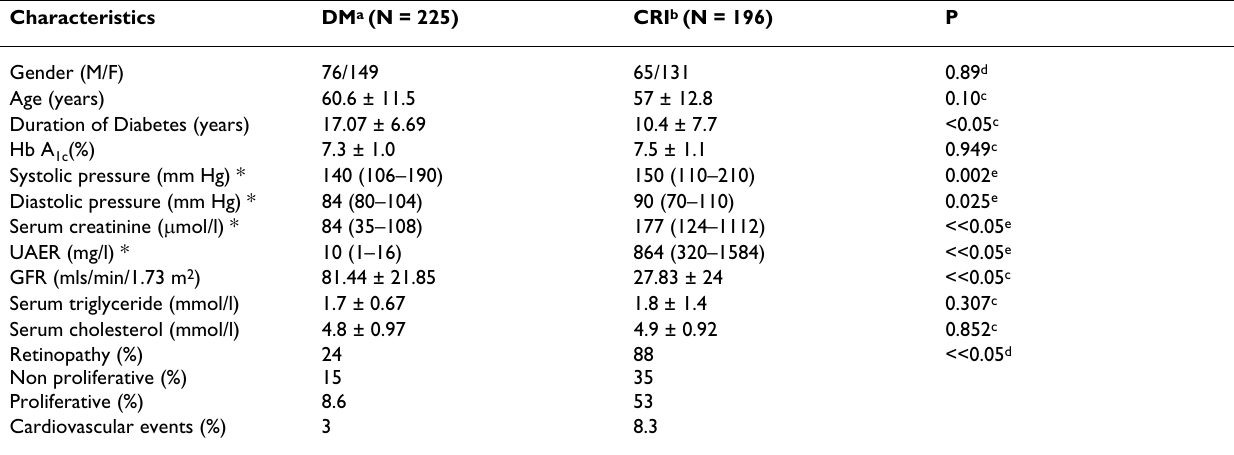
Table 2: Clinical characteristics of the study population